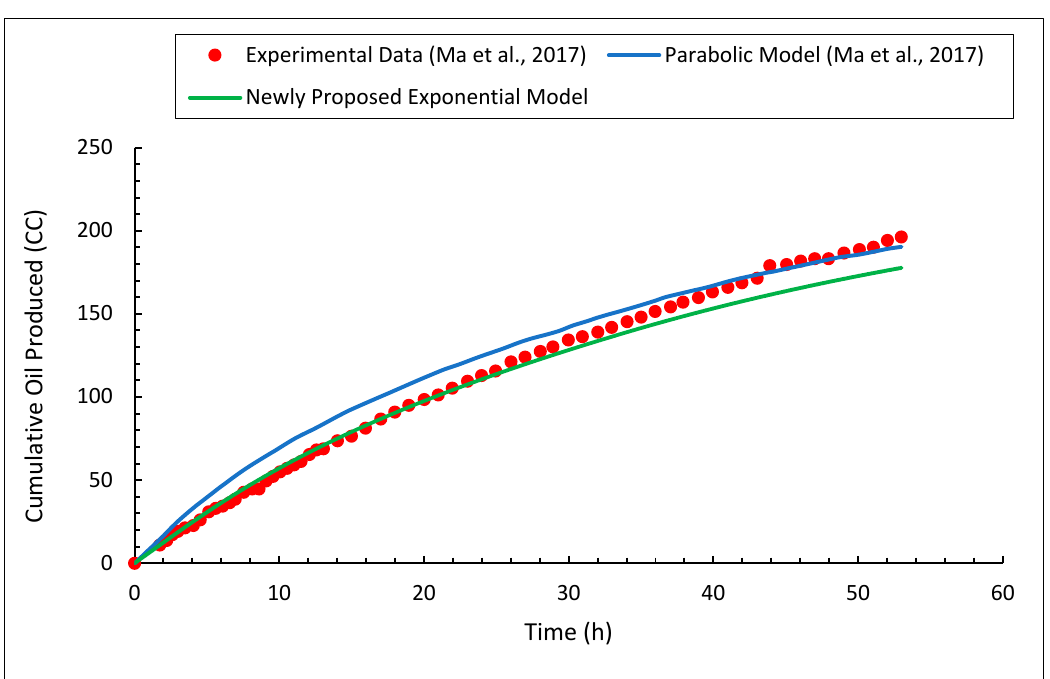
Figure 22. Comparison of the cumulative produced oil estimated by the newly proposed exponential model, experimentally measured cumulative produced oil [3], and cumulative produced oil estimated by the parabolic model proposed by Ma et al. [3] in test #2.